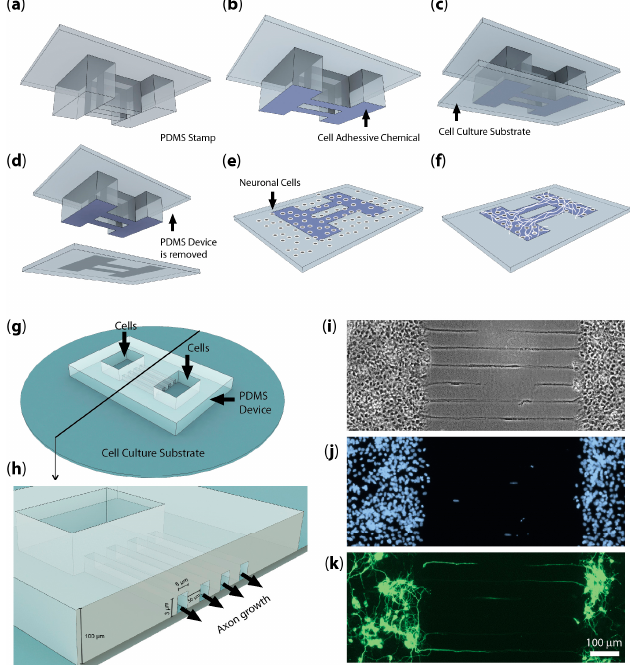
Figure 2. Techniques for patterning dissociated neuronal cultures: micro-contact printing with polydimethylsiloxane (PDMS) stamp ( a – f ), and physical confinement with a PDMS well/microchannel device ( g – k ). ( a ) Microfabricated PDMS stamp; ( b ) The bottom part of the device is submerged in a cell adhesive chemical; ( c ) A cell adhesive chemical attached to PDMS stamp is pressed against a cell culture substrate to print a cell adhesive pattern onto it; ( d ) The stamp is removed; ( e ) neurons are seeded onto the cell culture substrate, and ( f ) after adequate time needed for cell adhesion, the culture medium is changed. This removes the un-attached cells leaving the attached cells along the printed cell adhesive pattern. With adequately thin strip geometry, only axons can grow on thin portions of the pattern; ( g ) PDMS device containing wells for neuron cell bodies and microchannels for axon growth between wells; ( h ) Cross-section of PDMS device with dimensions (not drawn to scale), micro-channel openings are visible; ( i ) Bright field image of separated neuronal culture with axonal connection after removing PDMS device; ( j ) DAPI-stained nuclei and ( k ) anti- β III Tubulin stained neuron soma, dendrites, and axons.